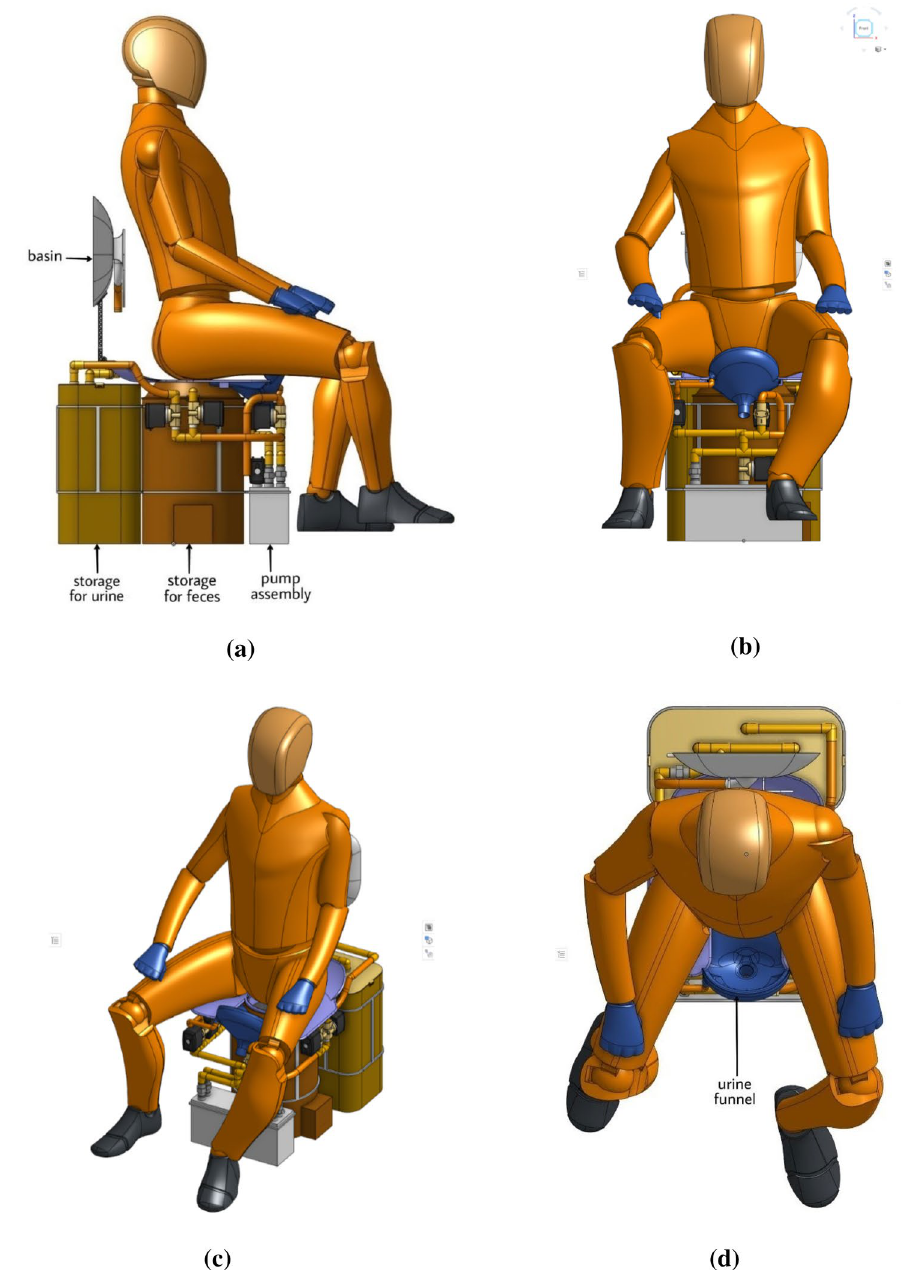
Fig. 1 Schematic representa- tion of different views of waste collection system (WCS). Astro- naut doing his/her regular stuff a side view, b front view, c isometric view, and d top